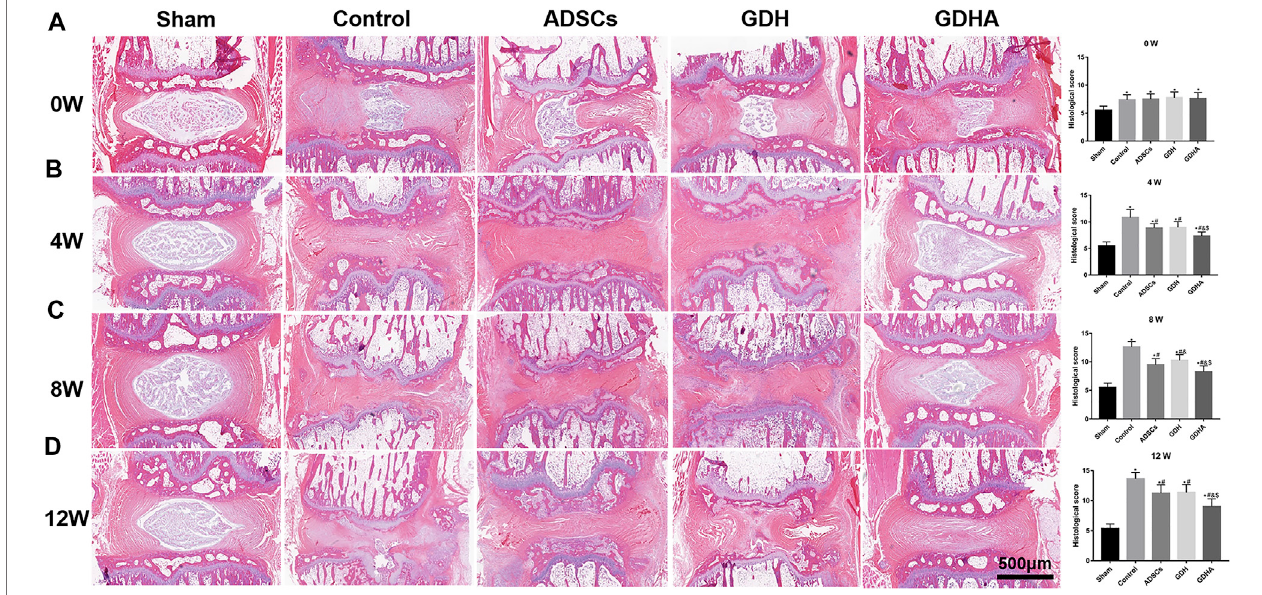
FIGURE8| TypicalHEstainingandhistologicscorechangeinthetaildiscsat0 (A) ,4 (B) ,8 (C), and12 (D) weeksafterinjection.Datarepresentedmean ± SD( n (cid:2) 5); * p < 0.05, vs. sham group; # p < 0.05, vs. control group; & p < 0.05, vs. ADSC group; $ p < 0.05, vs. GHD group. Scale bar (cid:2) 500 μ m.